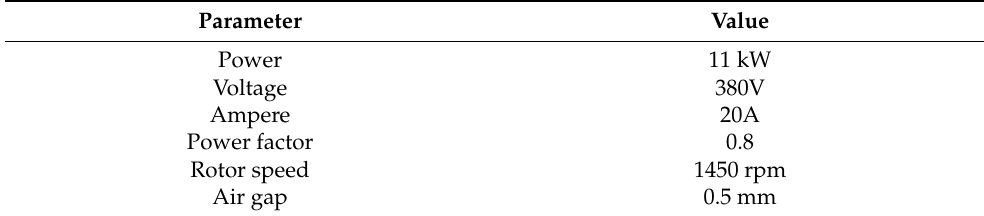
Table 1. The parameter of the three-phase induction motor [22].